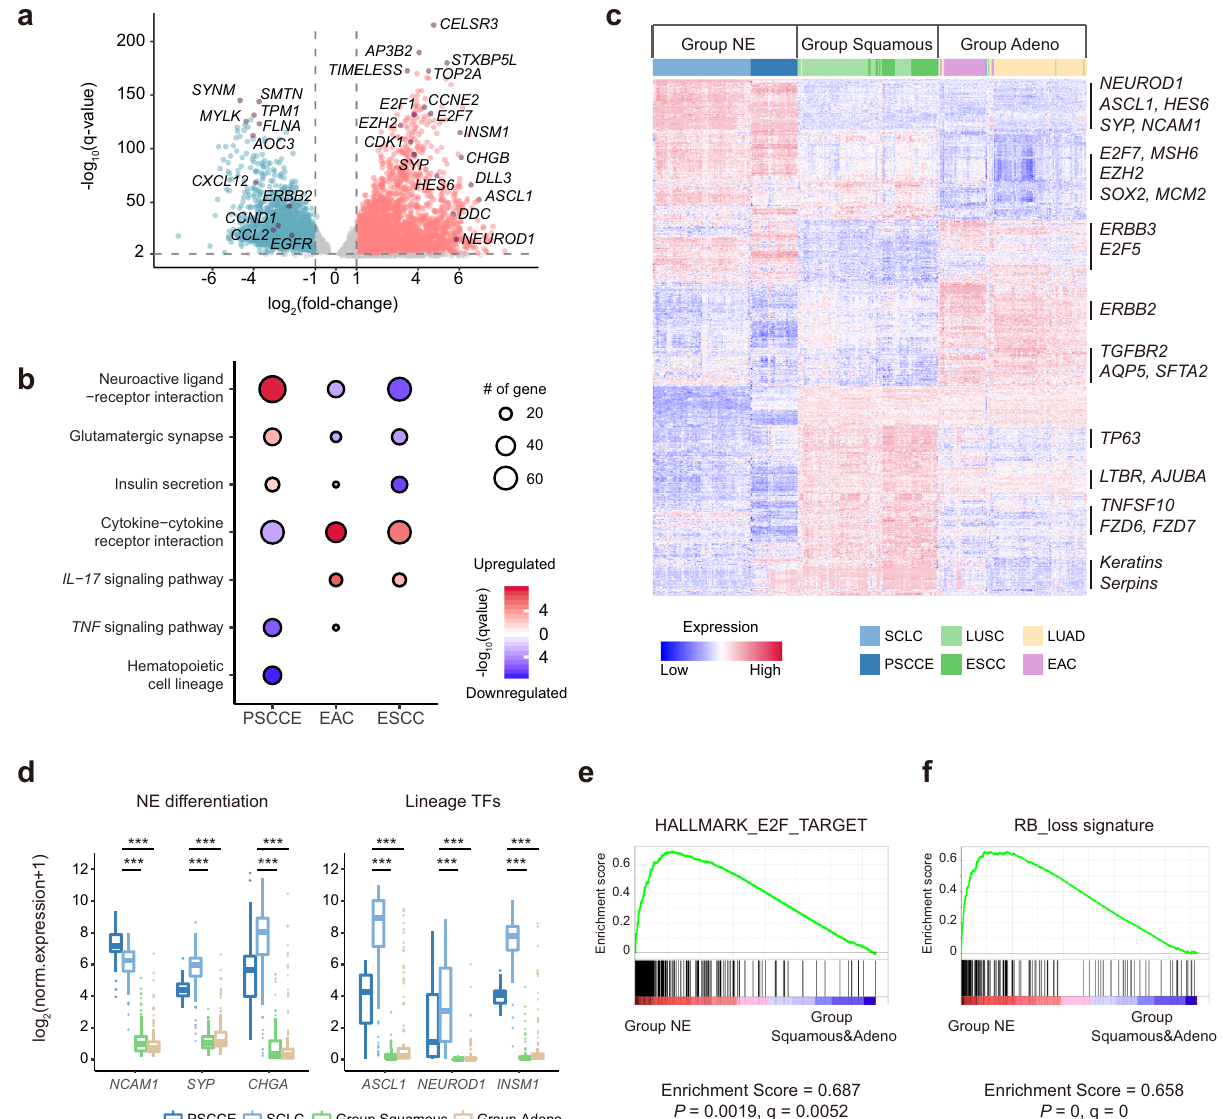
Fig. 3 The transcriptome landscape of PSCCE. a Volcano plot of differentially regulated genes (DEGs). Up- and downregulated DEGs are plotted in red and cyan, respectively. Key genes are plotted in purple with symbols annotated. Source data are provided as a Source Data fi le. b Pathways that were largely discordant between PSCCE, EAC, and ESCC. c Heatmap of gene expressions of three principle clustering groups. Key signature genes associated with clustering are marked on the right side. d Expression of neuroendocrine differentiation marker genes and lineage transcription factors across three groups. PSCCE and SCLC samples are plotted separately to show that there was no hijacking of either cancer by the other. The upper bound, centerline, and lower bound of boxplot represent the 75 percentile, the median and the 25 percentile of data; the upper and lower whiskers extend to the largest and smallest value within 1.5 times of interquartile range (IQR) from corresponding bound. Data beyond the whiskers are plotted as outlier dots. *** P < 0.001, by the Wilcoxon rank-sum test. e GSEA revealed that E2F target genes were speci fi cally expressed in Group NE. f GSEA revealed that RB1 -loss associated genes were speci fi cally expressed in Group